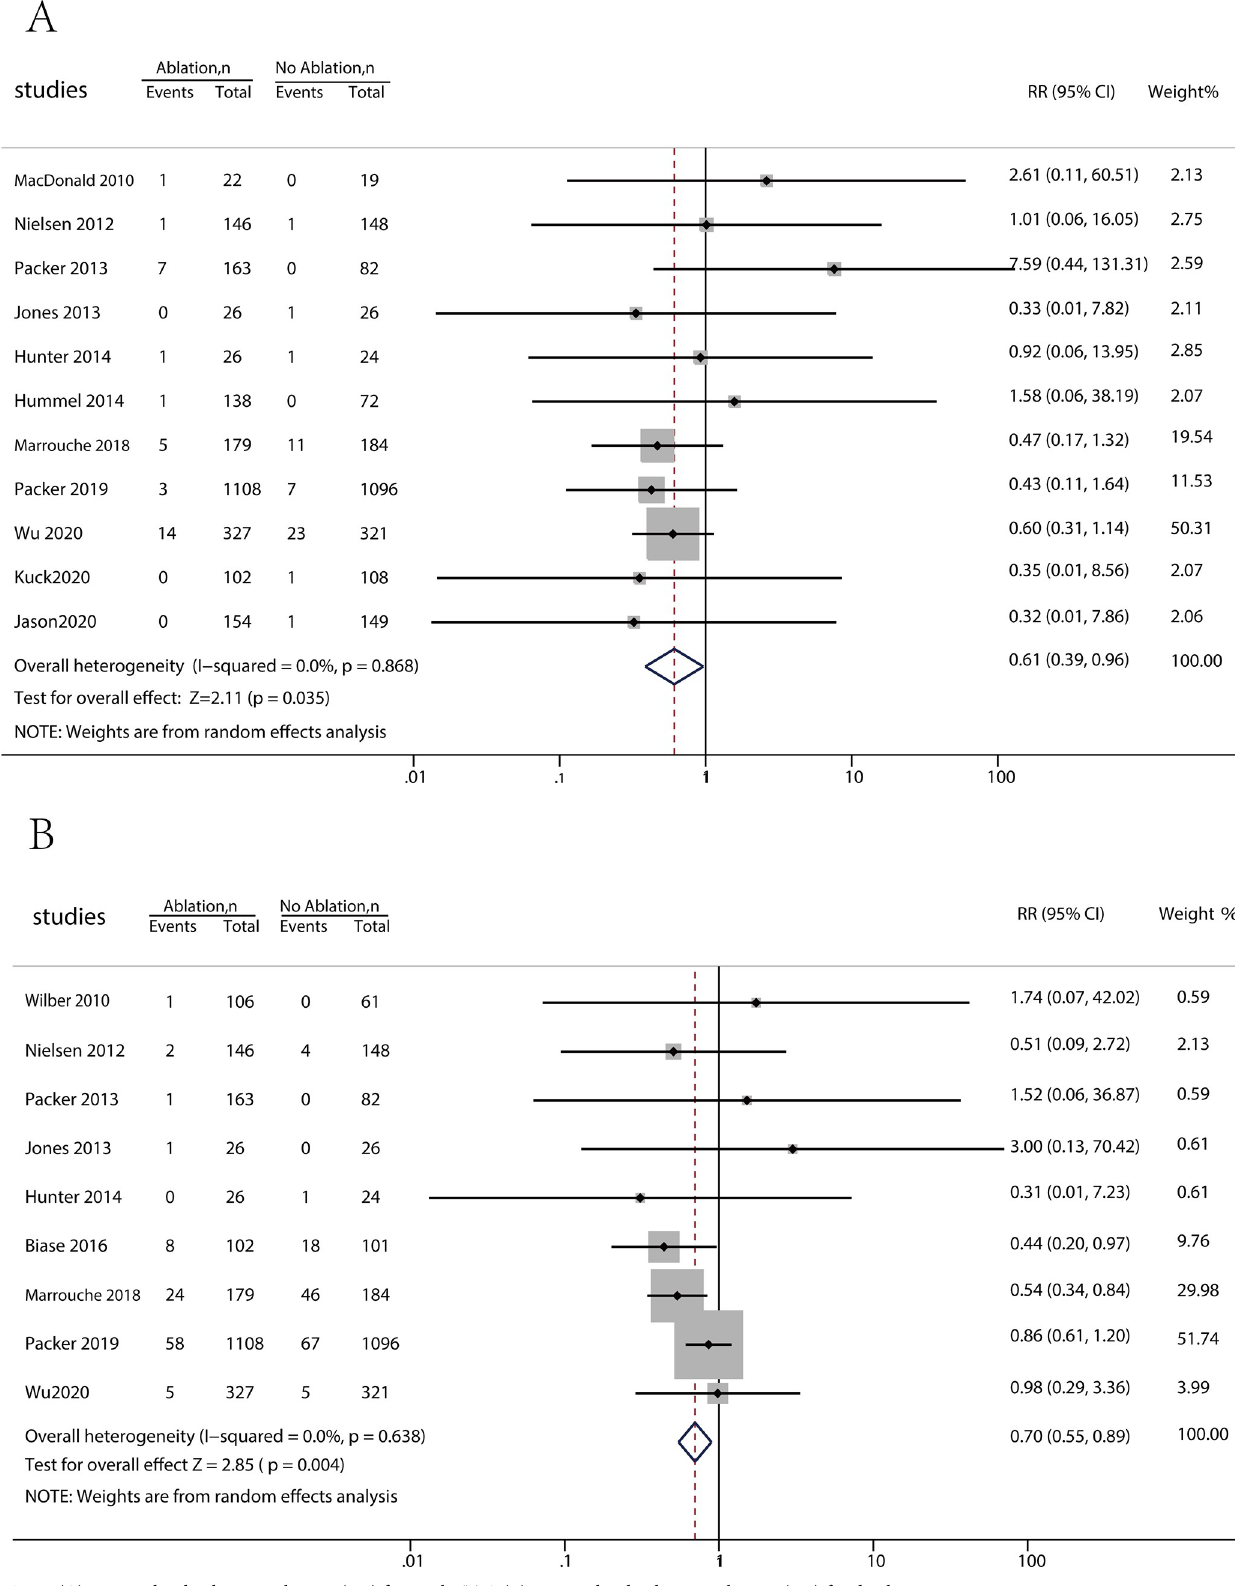
Fig 2. (A) Forest plot displaying risk ratio (RR) for stroke/TIA (B) Forest plot displaying risk ratio (RR) for deaths. https://doi.org/10.1371/journal.pone.0262702.g002 PLOS ONE | https://doi.org/10.1371/journal.pone.0262702 January 19,